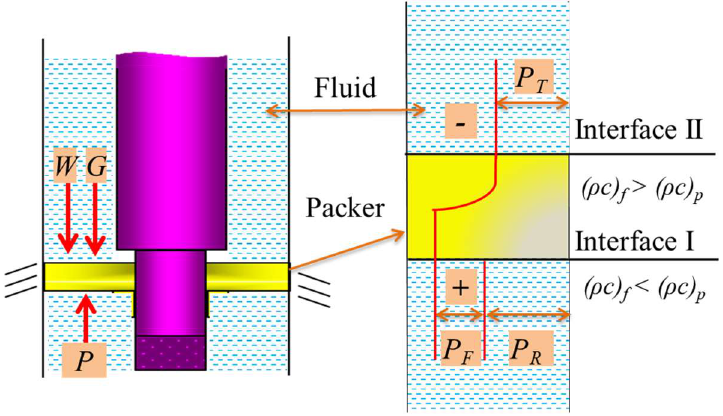
Figure 15. Perforating pressure on packer with different installation positions of shock absorbers.